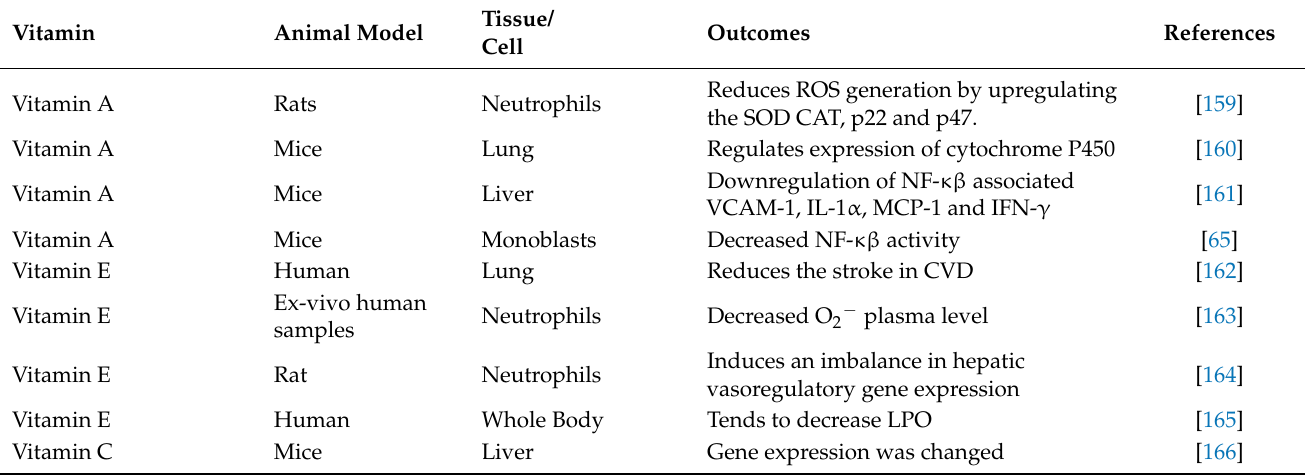
Table 3. Antioxidants investigated in sepsis and used in animal and clinical